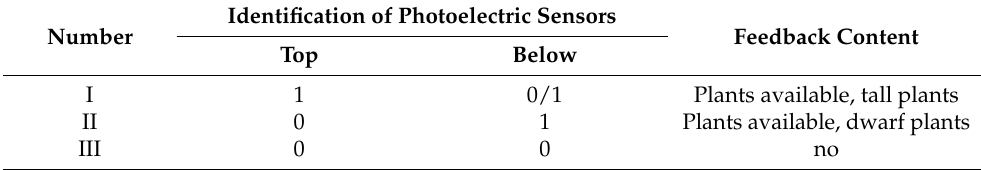
Table 3. Photoelectric sensors’ specific feedback signal. Identification of Photoelectric Sensors Number